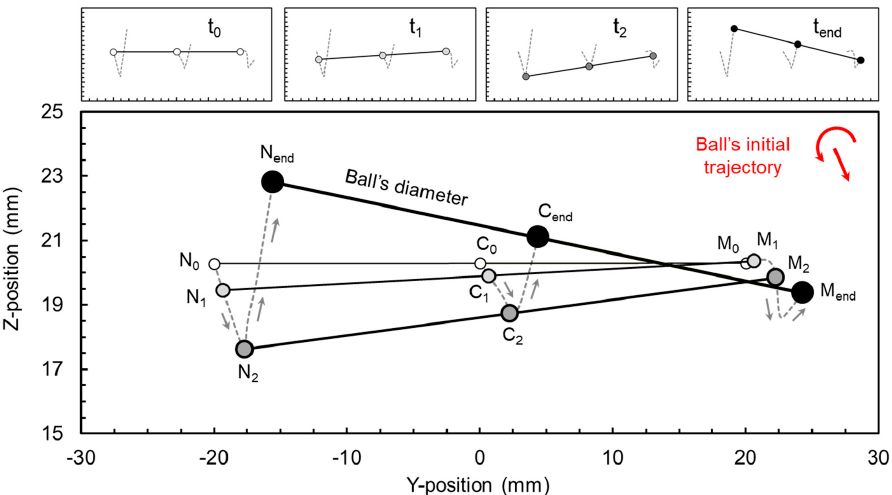
Figure 10. In-plane trajectories of the M, N and calculated C points of the ball. ( α i = 60° angle, V i = 14 m/s and ω i = − 66 rev/s). N.B. different scales were used for y and z.